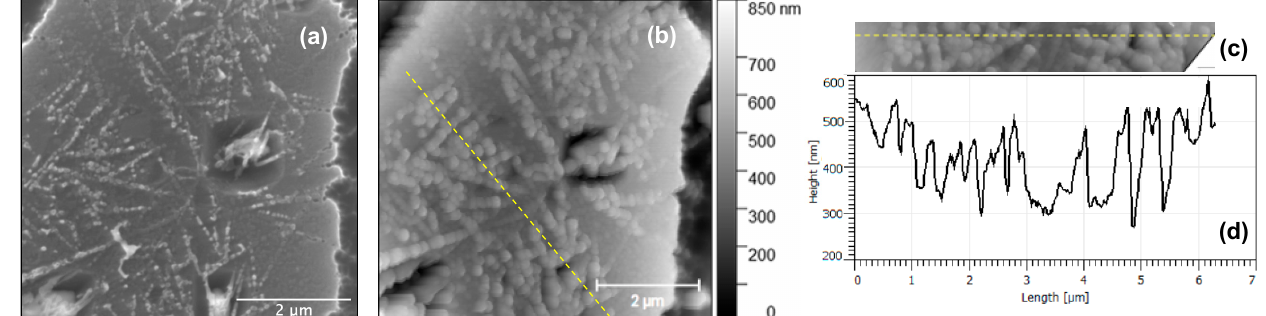
Figure 4. ( a ) Plan-view SEM micrograph of a region with nano-trees (a micro-crucible with a small opening) and ( b ) an AFM micrograph of the same region. The dashed yellow line shows a region of interest for a height profile analysis, cropped and realigned in ( c ), in which the resulting height profile is shown in ( d ).